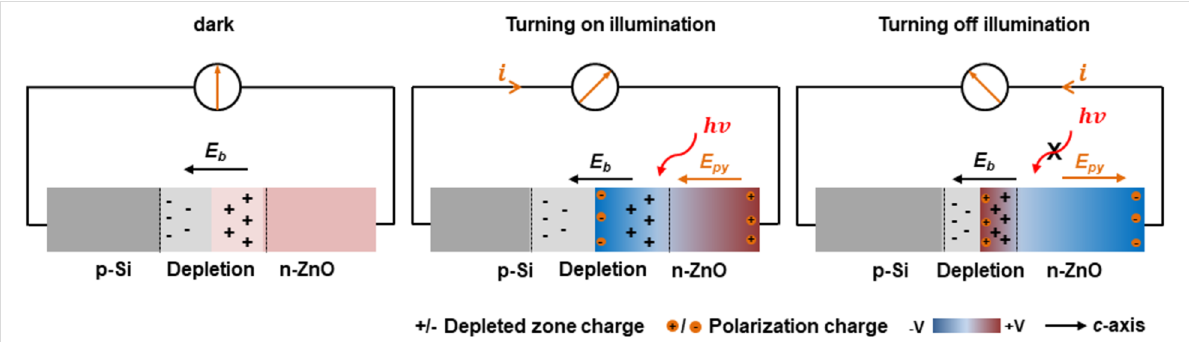
Figure 2: Working mechanism of PENGs. under zero bias, a depletion zone and corresponding built-in electric field are formed without illumination (left). Upon illumination, the pyroelectric electric field and transient output current are generated (middle). Reverse pyroelectric field and reverse tran- sient output current are generated at the moment of turning off illumination (right).